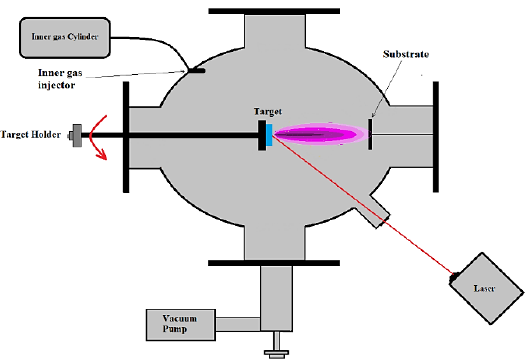
Figure 20. PLD laser construction setup.